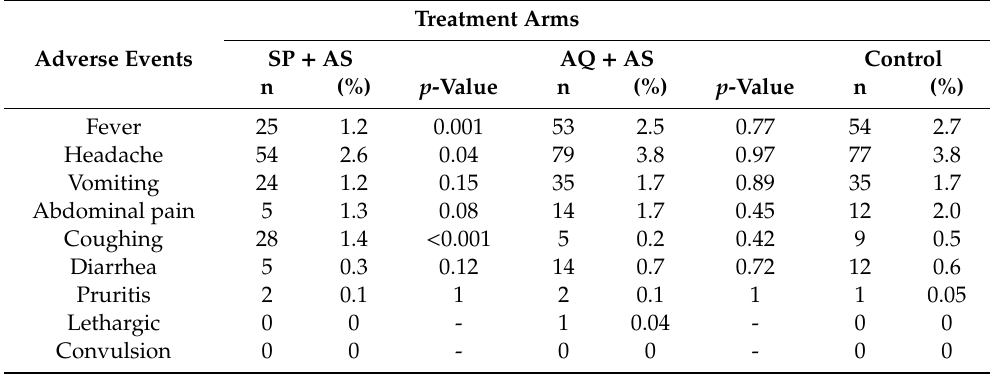
Table 5. The Proportion of Adverse events of All Years in School-Aged Children During Two Rounds of IPTsc Treatment Using Passive and Active